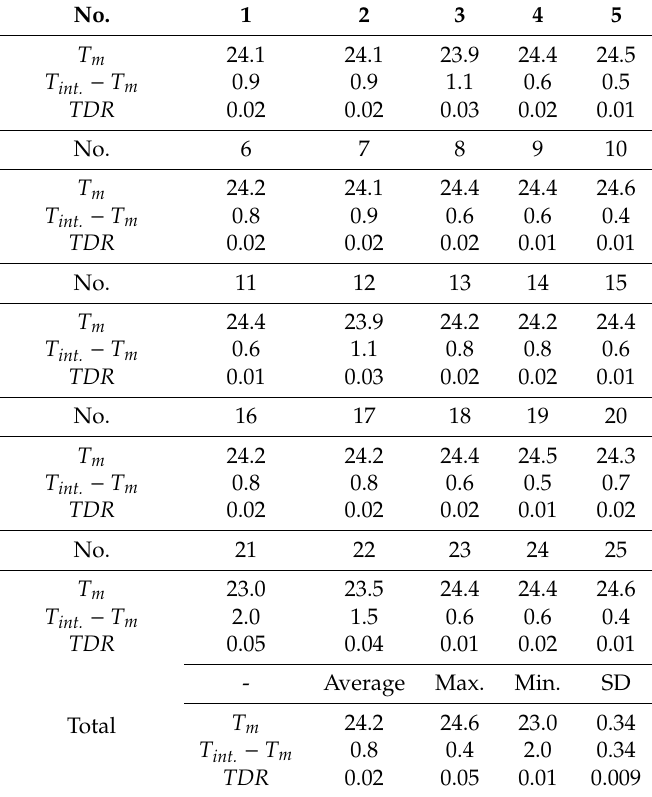
Table 4. Test results of condensation risk (Unit: °C).